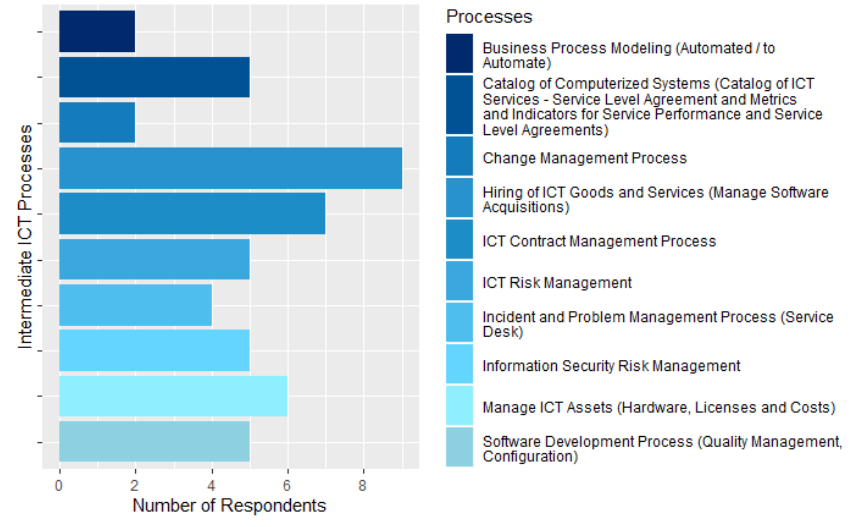
Figure 9. Intermediate ICT processes.